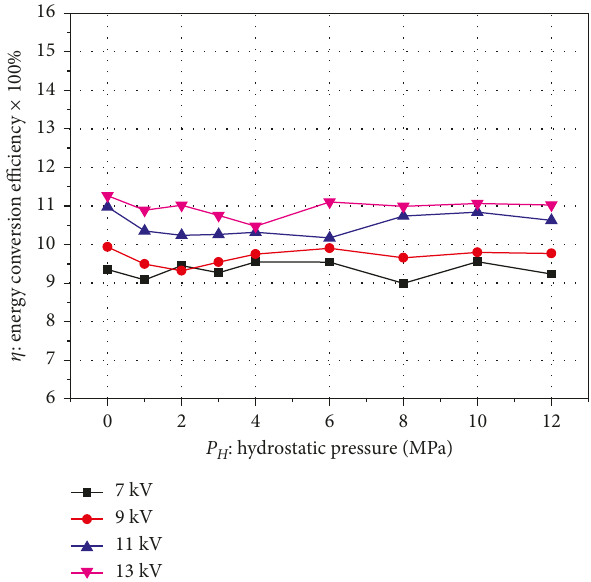
Figure 8: Variation diagram of η versus P